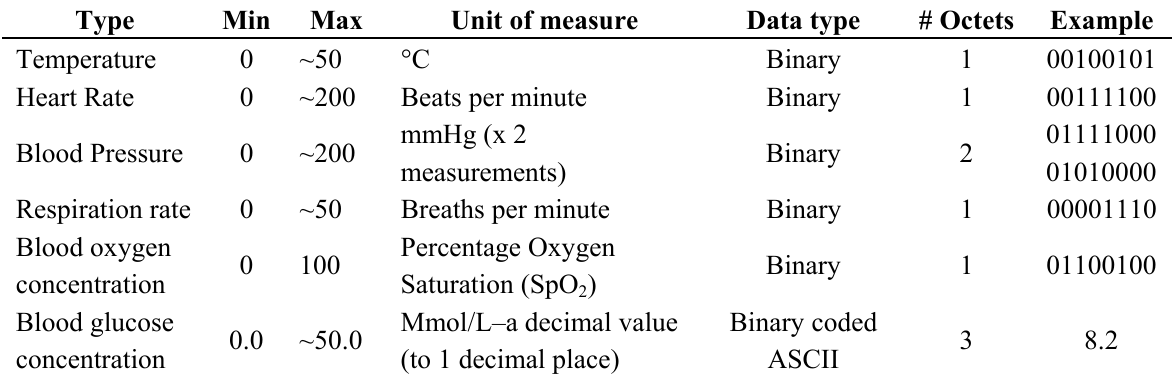
Table 1. Vital signs data-summary of ranges and types of